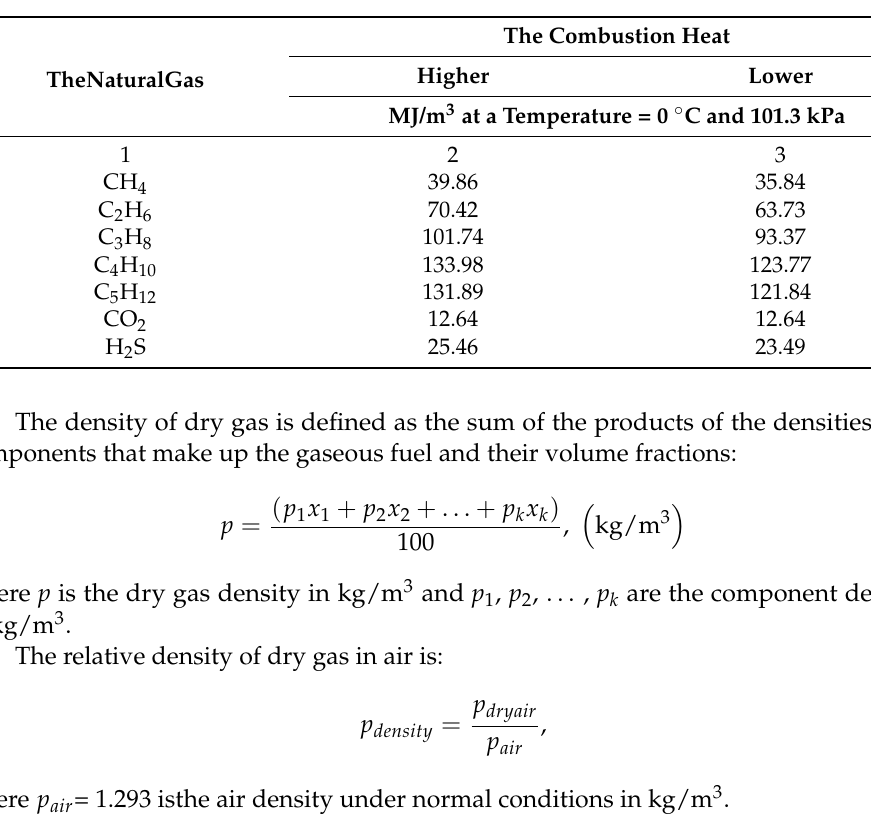
Table 3. The combustion heat of pure combustible gases. TheNaturalGas